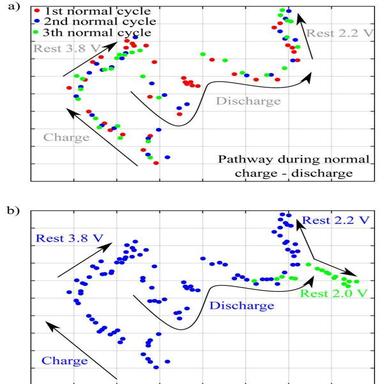
Mapping for UD of prismatic cell. a) Normal cycling; b) All the cycles.